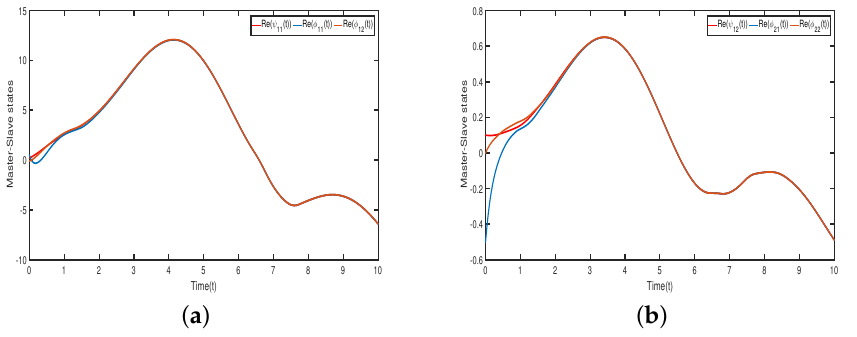
Figure 1. ( a ) The real parts of state trajectories of CVNNs (23) and (24) for h = 1, i = 1. ( b ) The real parts of state trajectories of CVNNs (23) and (24) for h = 1, i = 2 .